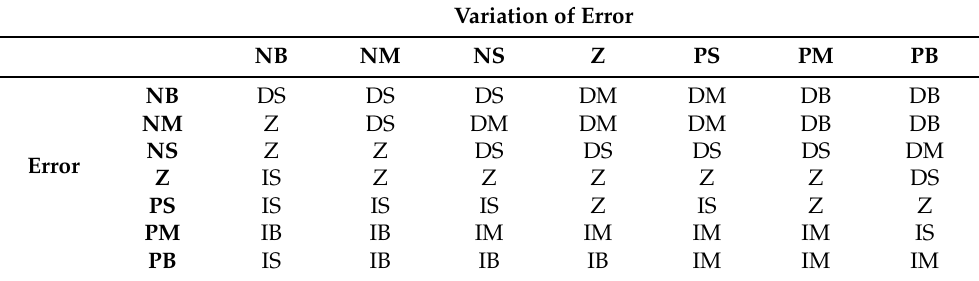
Table 1. Fuzzy control